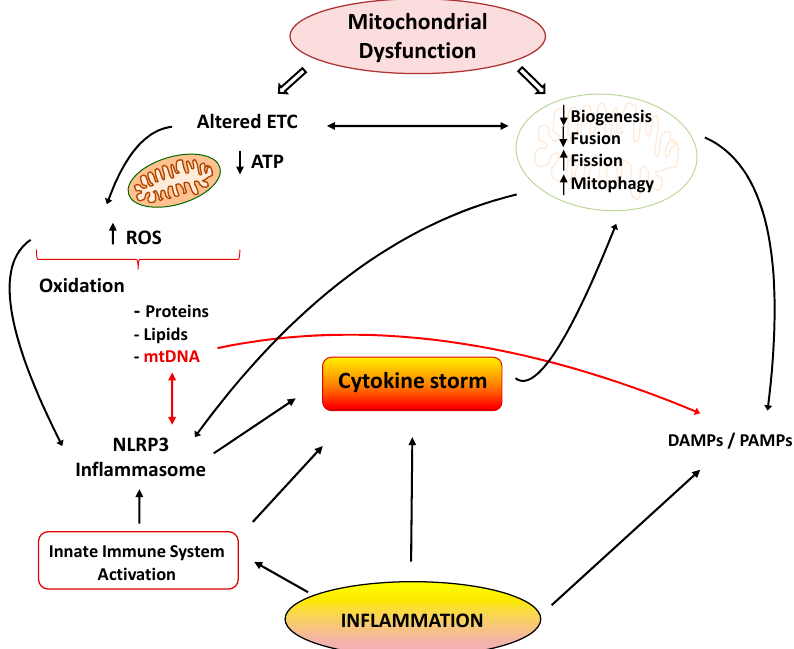
Figure 1. Cytokine storm: link between inflammation and mitochondrial dysfunction. ETC: electrons transport chain; ROS: reactive oxygen species; NLRP3: NOD-, LRR- and pyrin domain-containing 3; DAMPS/PAMPS: damage/pathogen-associated molecular patterns.